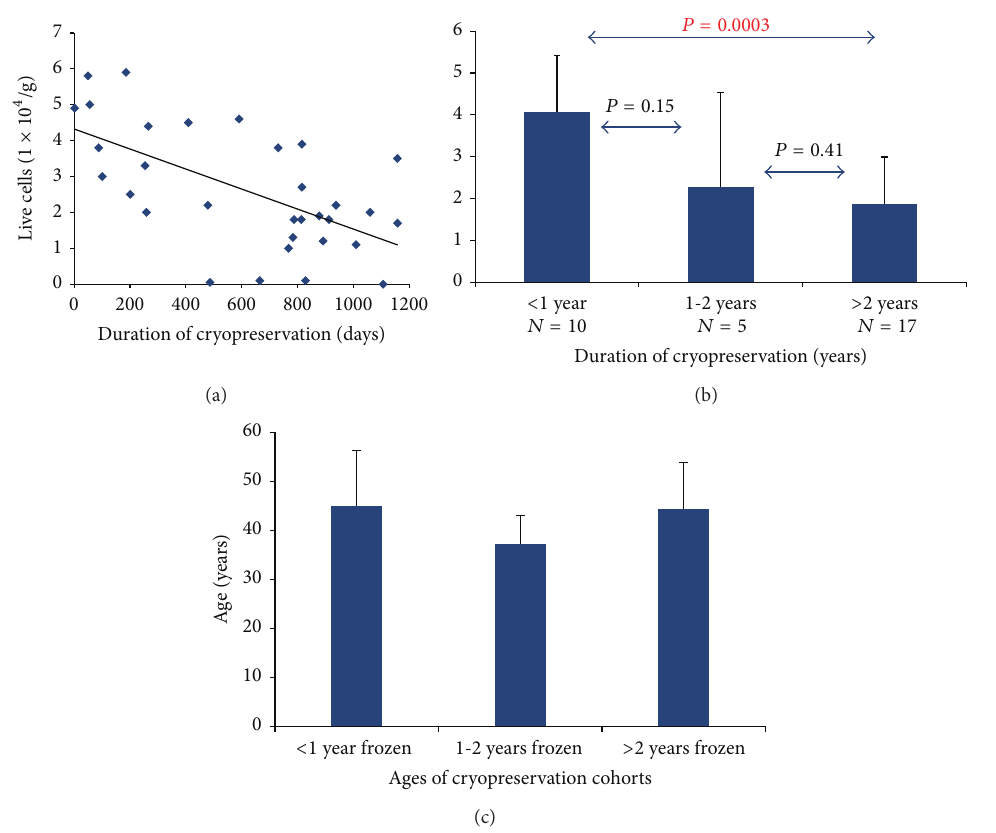
Figure 1: Live ASC isolation relative to duration of cryopreservation. (a) ASCs were isolated from 32 patients whose adipose tissue was cryopreserved for varying amounts of time (range 2–1159 days, average 596.4 × 10 4 ± 369.9 × 10 4 cells/g tissue). Live ASCs isolated ranged from 0 to 95. 5 × 1 0 4 cells/g adipose, average 63.8 × 10 4 ± 30.6 × 10 4 cells/g tissue, showing a trend toward decreased live ASC isolation with increasing ASC cryopreservation duration. (b) Live cell count was compared relative to cryopreservation duration in 3 cohort groups: < 1 year ( 𝑁 = 10 ), 1-2 years ( 𝑁 = 5 ), and > 2 years ( 𝑁 = 17 ). A significant decrease in live ASC isolation was observed between the > 2 years and < 1 year cryopreservation duration cohorts; 𝑃 = 0.0003 . (c) Patient age was compared for each of the cryopreservation cohort groups and no significant differences were found between any group; 𝑃 > 0.05